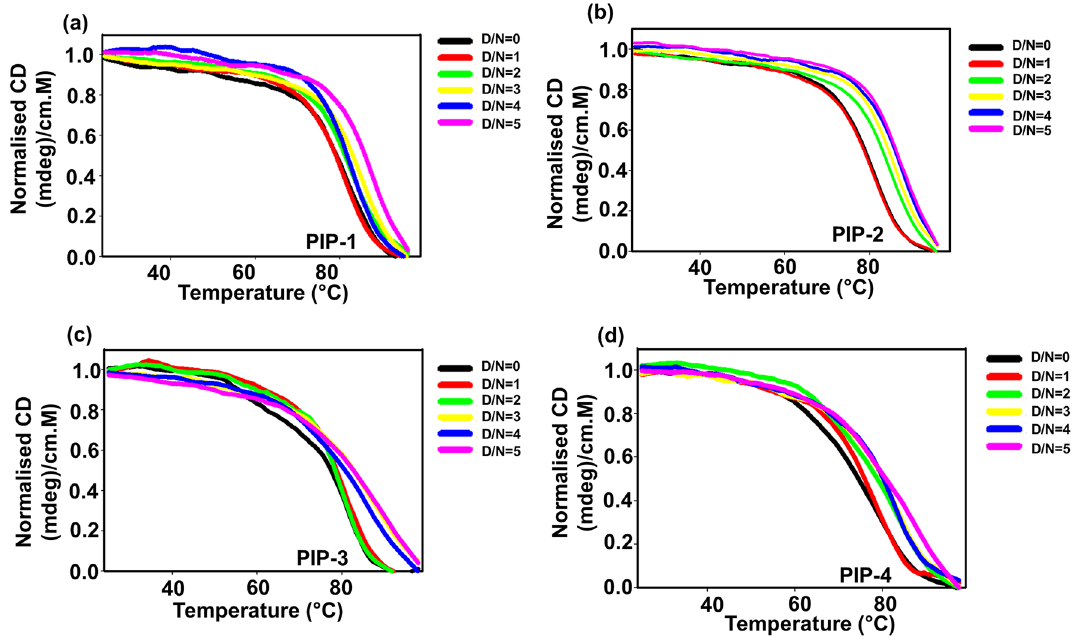
Figure 5. CD melting graph of Piperine analogs with c-myc G4 DNA ( a – d ) Representative CD melting graphs showing the change in melting temperature of c-myc G4 DNA (10 µM) in the absence (D/N = 0) and presence of different Piperine analogs (D/N = 5) ( a ) PIP-1, ( b ) PIP-2, ( c ) PIP-3 and ( d )